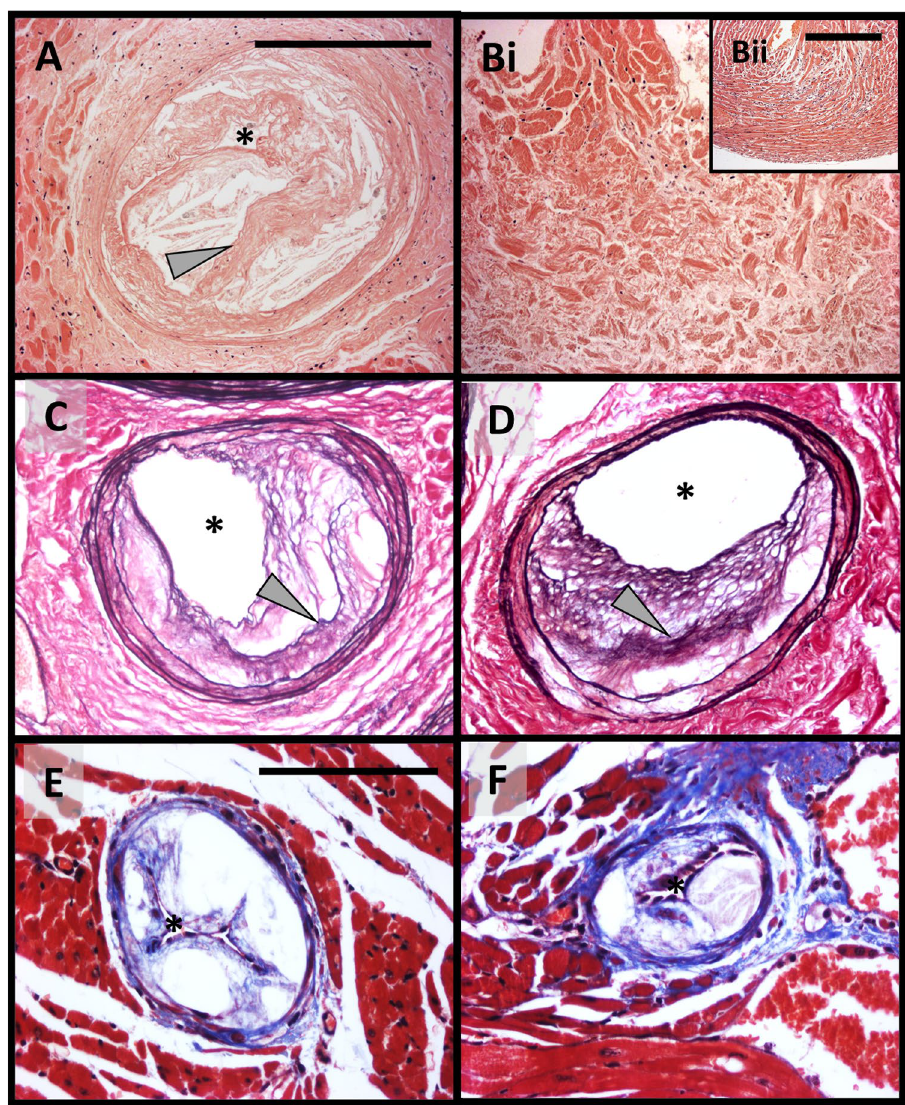
Figure 2. Representative atherosclerotic coronary arteries with signs of healed plaque rupture, alongside evidence of myocardial infarction. ( A and B ) Haematoxylin and eosin stained ( A ) proximal left anterior descending coronary artery with a large atherosclerotic lesion harbouring a healed plaque rupture (arrow), within (Bi) a heart with a large area of infarction alongside (Bii) healthy myocardium, from a 36-week high-fat fed Apoe -/- mouse. ( C and D ) Elastin van Gieson stained proximal coronary artery lesions exhibiting healed plaque ruptures (arrows), from a 36-week high-fat fed Apoe -/- mouse. ( E and F ) Masson trichrome stained distal coronary arteries harbouring large occlusive atherosclerotic lesions, from a 36-week high-fat fed Apoe -/- mouse. Asterisk indicates lumen. Scale bar in Panel A represents 200 μm and is applicable to Panels ( A ), Bi, ( C and D ). Scale bar in Panel Bii represents 200 μm. Scale bar in Panel ( E ) represents 100 μm and applies to Panels ( E and F